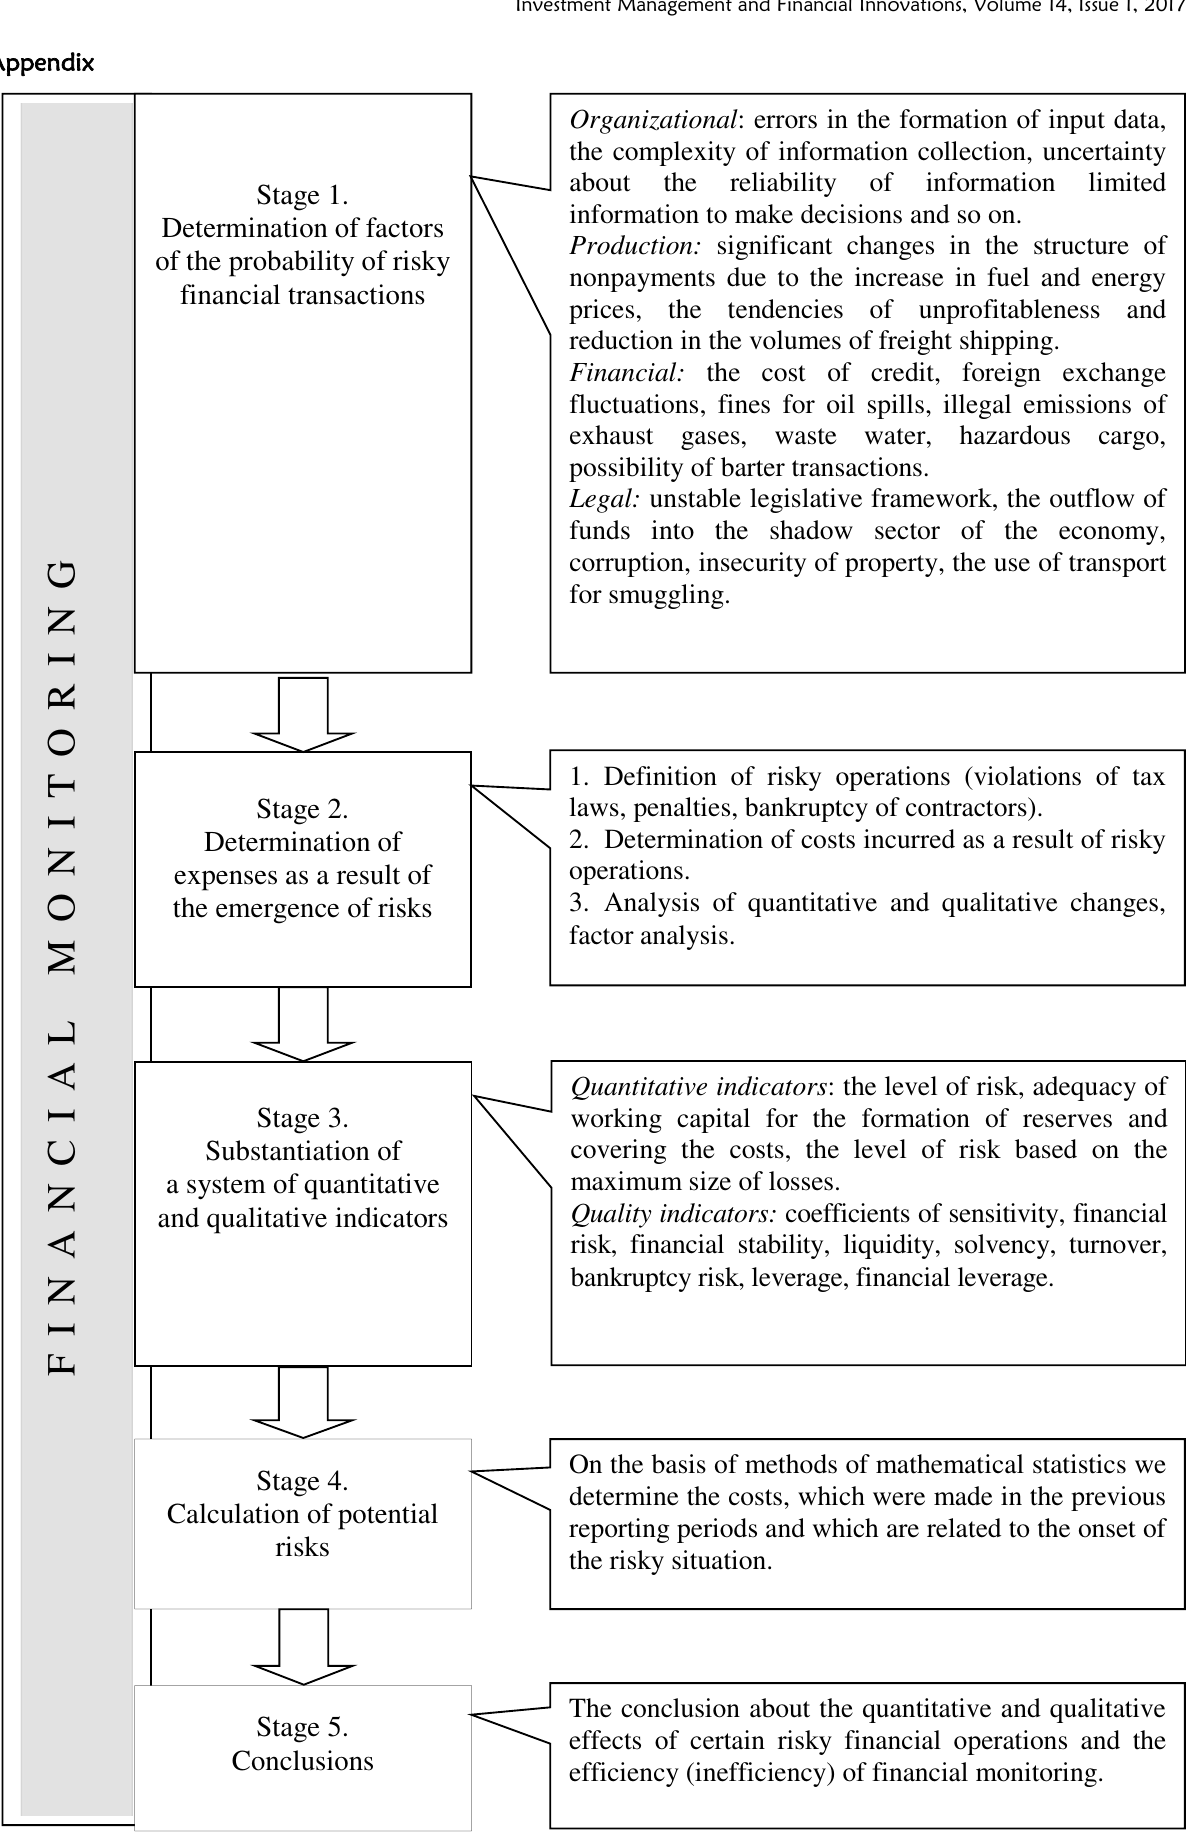
Fig. 1. Methodical approach to financial monitoring of the port industry companies on the basis of a risk-based